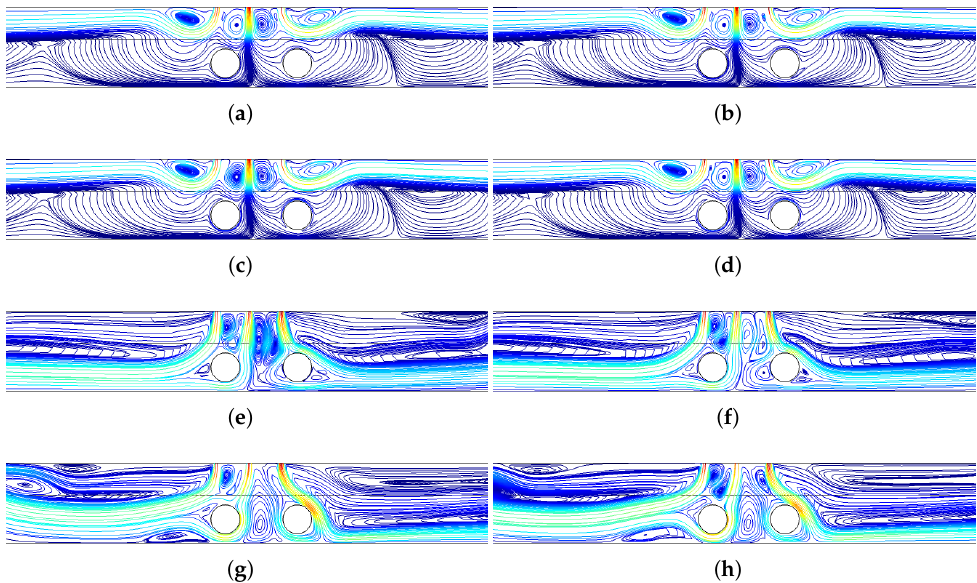
Figure 4. Effects of Rew on streamline variations at two different permeabilities of the embedded zone (Re = 300, sc = 3Rc, HNF-2%). ( a ) Rew = − 100, Da = 0.0001; ( b ) Rew = − 200, Da = 0.0001; ( c ) Rew = − 400, Da = 0.0001; ( d ) Rew = − 500, Da = 0.0001; ( e ) Rew = − 100, Da = 0.1; ( f ) Rew = − 200, Da = 0.1; ( g ) Rew = − 400, Da = 0.1; ( h ) Rew = − 500, Da =